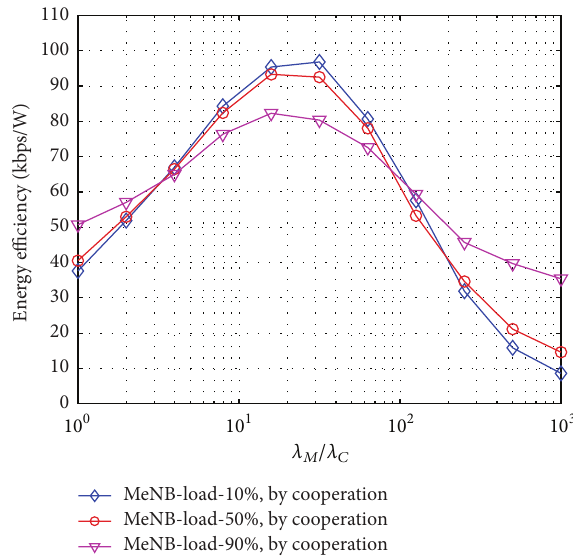
Figure 3: Energy efficiency in full reuse HetNet with different MBS load.